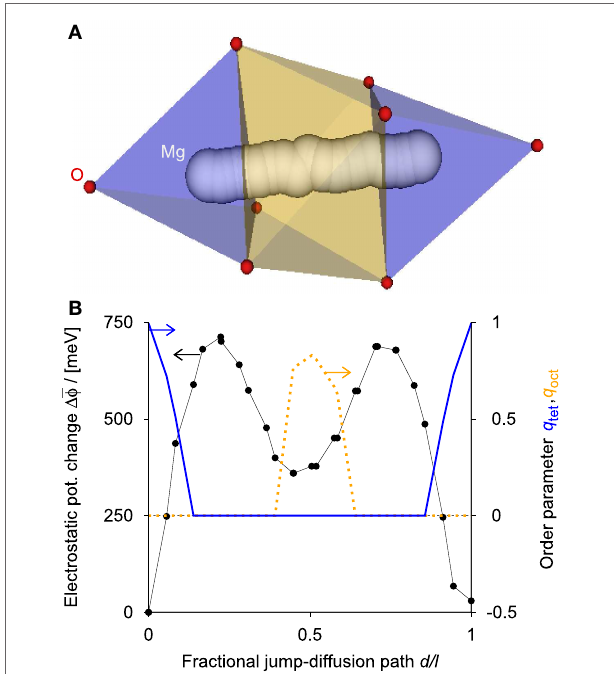
FIGURE 11 | (A) A magnesium ion (white spheres) hops in Mn 2 O 4 -spinel from a site at which it is coordinated by four oxygen atoms (red spheres) in a tetrahedral manner (blue polyhedron) through an intermediate O-octahedron (orange) back into a tetrahedral site. (B) Change in electrostatic potential, ∆¯ φ (left abscissa, black circles and line) and tetrahedral (blue solid line), q tet , as well as octahedral order parameter (orange dotted line), q oct (both: right abscissa) as functions of the fractional jump-diffusion path, d / l . Note that the electrostatic potential is averaged over a spherical volume of radius 1.475Å; Zimmermann and co-workers are currently aiming to publish the underlying method. Furthermore, our diffusion path characterization method is robust as the additional spinel examples in the Supplemental Material (Figure S2 in Supplementary Material)